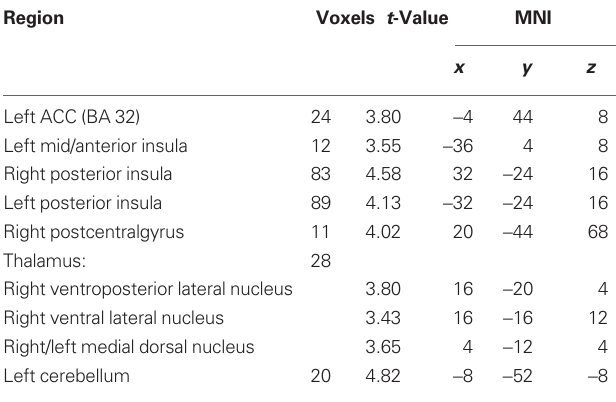
Table 2 | Within group main effects of unfairness for human conditions [meditators unfair > meditators fair].